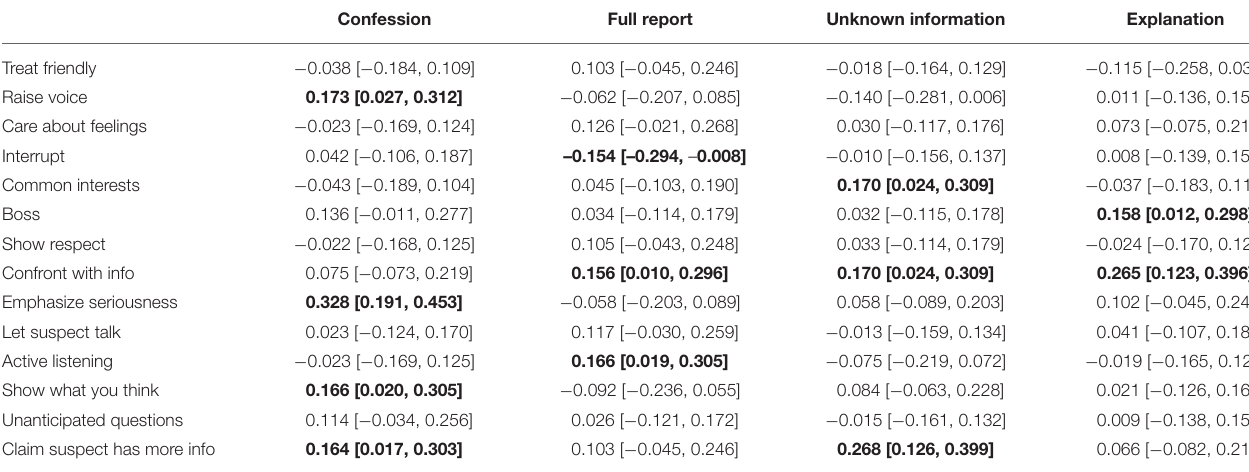
TABLE 5 | Bivariate correlations and 95% confidence intervals of interview tactics and goals.